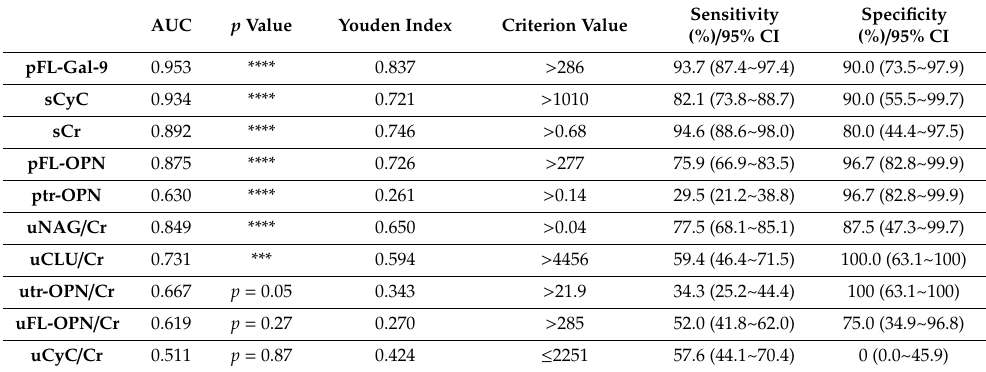
Table 1. Summary of ROC curve analysis.